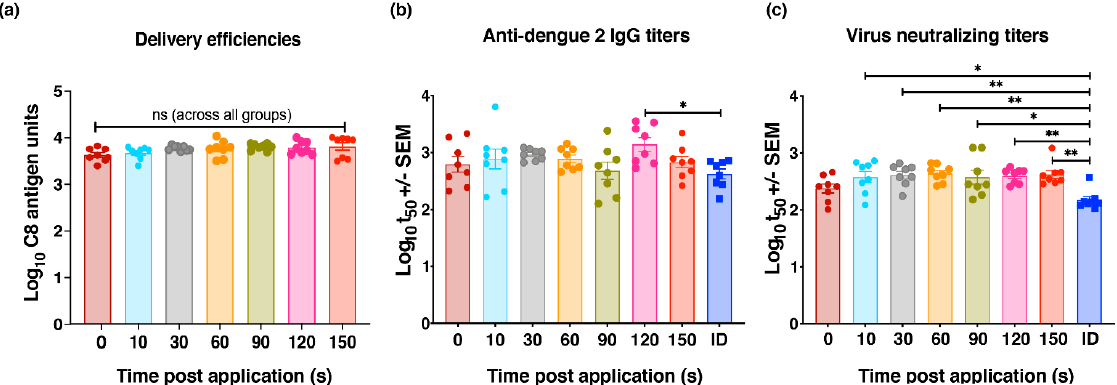
Figure 5. Optimization of HD-MAP wear time. ( a ) bDENV2 delivered by HD-MAP after different wear times post-appli- cation. C8 antigen capture ELISA was performed to analyze the amount of vaccine delivered. The bar graph represents the mean of bDENV2 ( n = 8) delivered by HD-MAPs across different wear times with error bars indicating SEM. ( b ) The IgG response for sera obtained after final vaccination was determined with mid-point (t50) antibody titers plotted. ( c ) Neutralizing antibody titers were determined for sera obtained 21 days post-vaccination against DENV2 ET00. Note: Each symbol represents a single mouse. The line indicates mean antibody titers with bars showing ± SEM. ** p ≤ 0.002, * p ≤ 0.03 assessed by one-way analysis of variance (ANOVA, α -level 0.05).